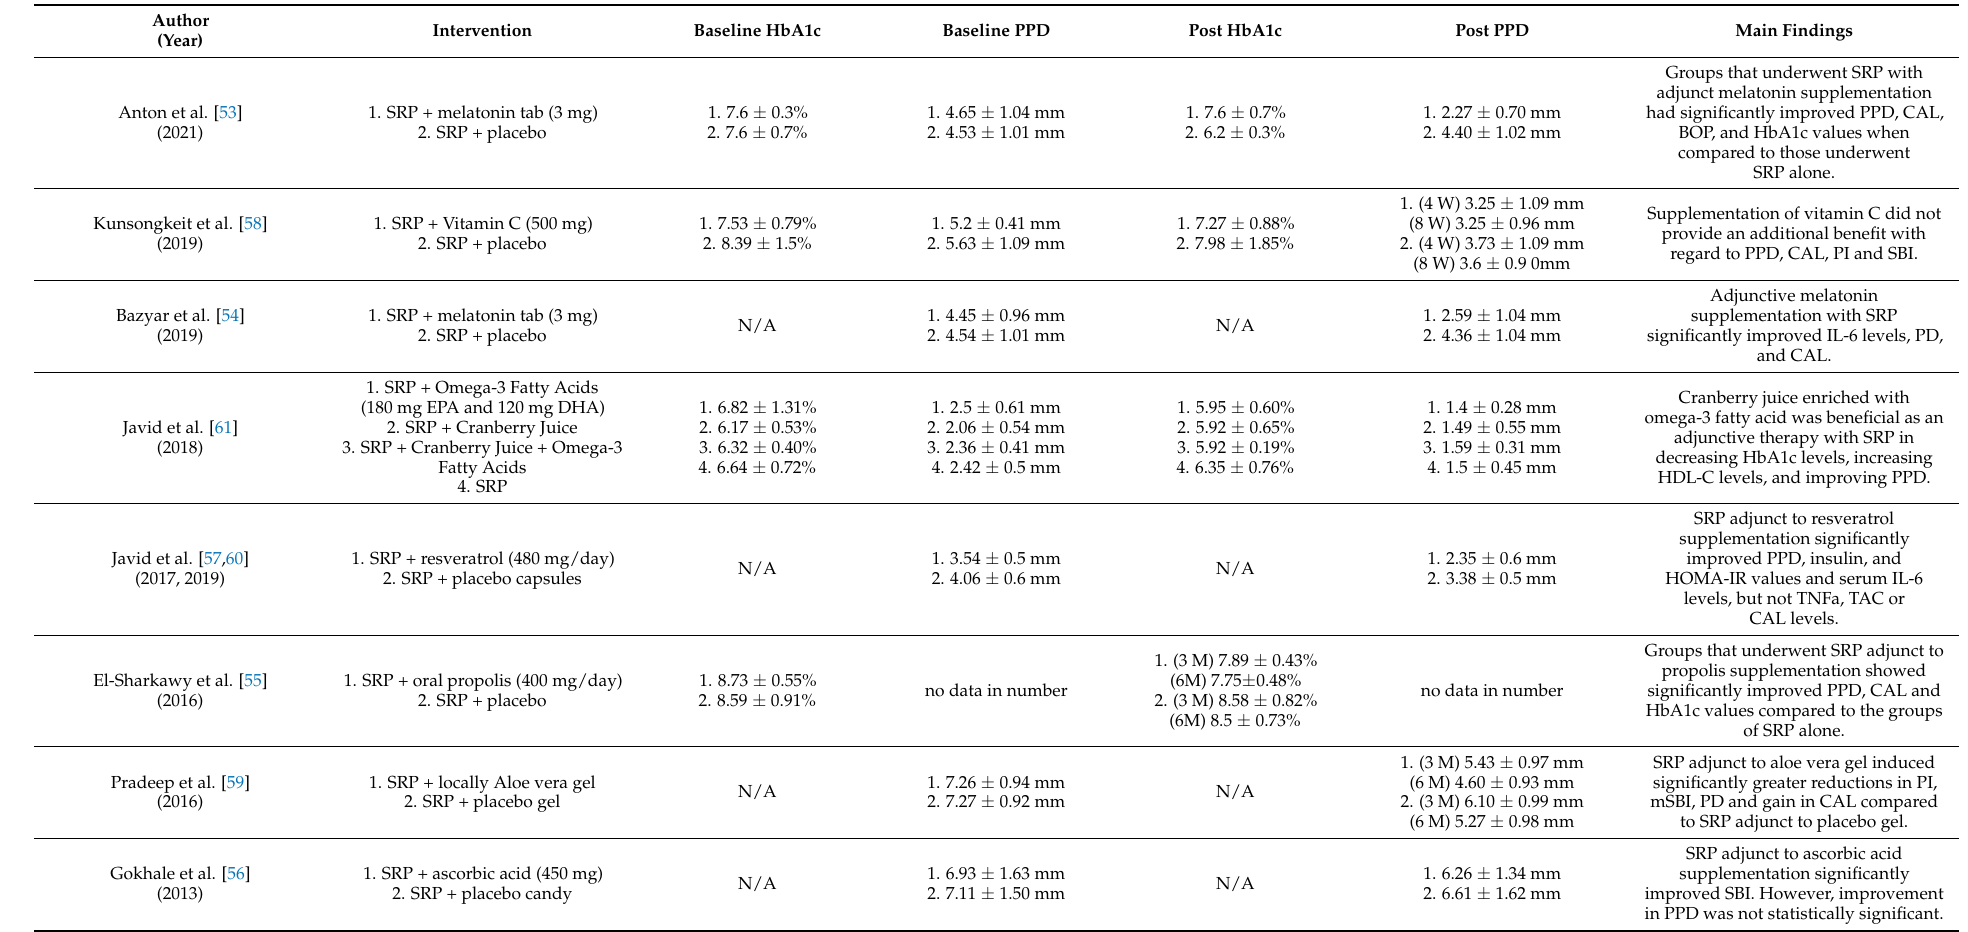
Table 2. Clinical parameters and antioxidants evaluated in the included